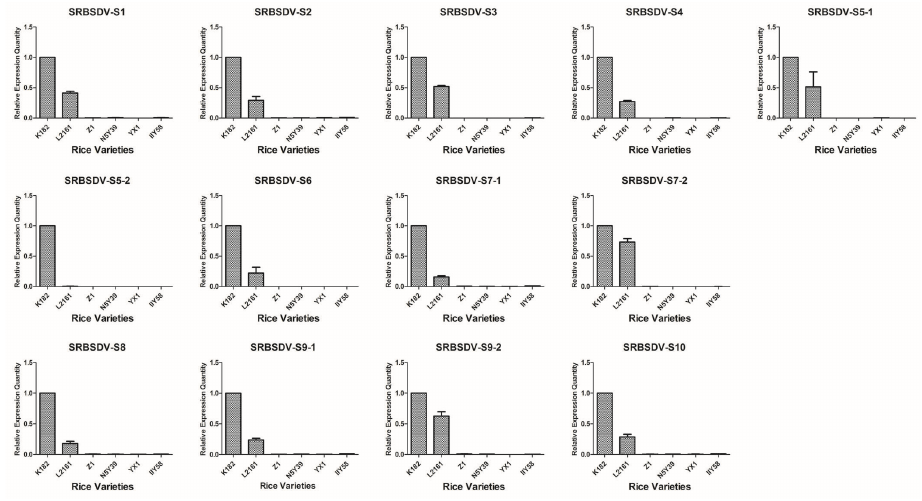
Figure 3. Map generated from the responses of six single infestation rice varieties to 13 SRBSDV genomes. All rice varieties consisted of K182, L2161, Z1, N5Y39, YX1, and IIY58.